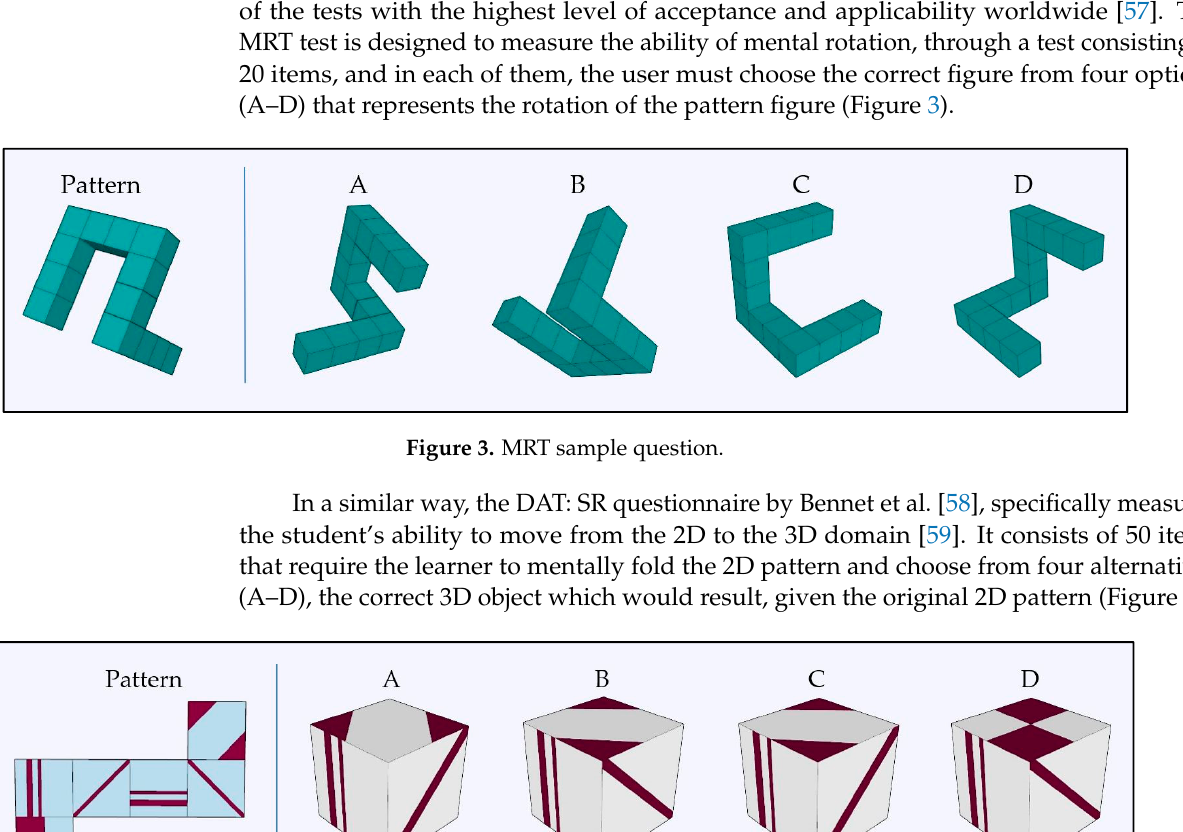
Figure 5. PSVT: R sample question. Finally, other specific tests with minimal frequency in the STEM subject area are used, related to very specific content, disciplines and methodologies. In the research fo- cused on the study of geometry developed by Dünser et al. [23], the Mental Cutting Test (MCT) and Objective Perspective Test (OPT) are used as assessment tools. In other work in the same field, Lin et al. [44] use the System Usability Scale (SUS) and NASA Task Load Index (NASA-TLX) assessment tools to validate their questionnaires. In order to assess the effectiveness of Civil Engineering students in the study of cartography, Carbonell and Bermejo [18] use the specific questionnaire Topographic Map Assessment (TMA) for the